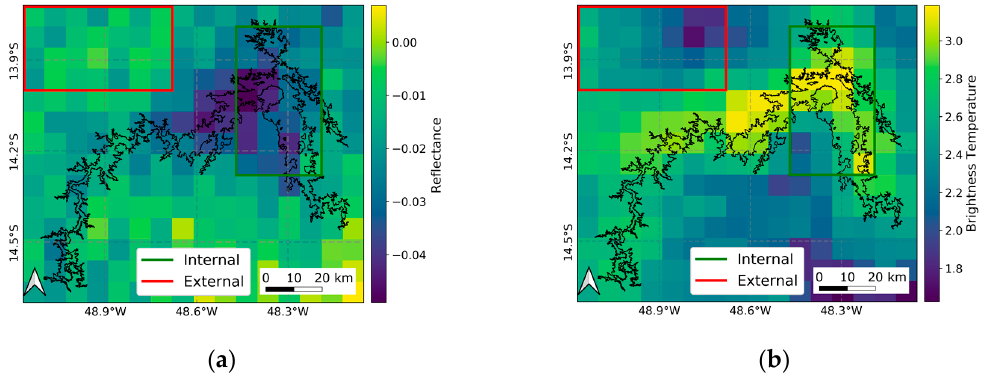
Figure 12. Mean differences (after–before) between periods after (1997–2009) and before (1984–1996) the reservoir construction over Serra da Mesa Basin for ( a ) visible reflectance (0.6 µ m) for 15 h LT and ( b ) daily infrared brightness temperature (11.0 µ m) in K. Green and red rectangles show domains for internal and external cloudiness evaluation.